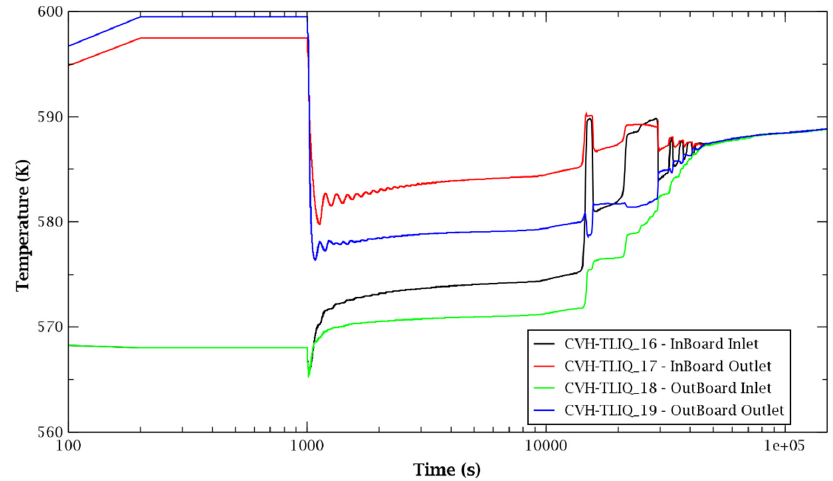
Figure 10. Temperature evolution in the BB: Case 3.